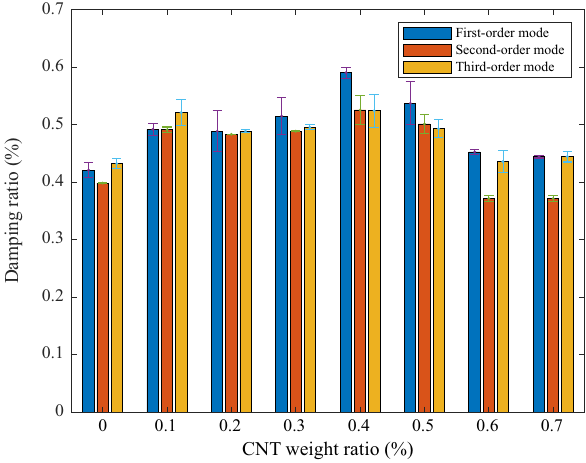
Figure 9: Damping ratios of the composite beams reinforced by CNT via vibration